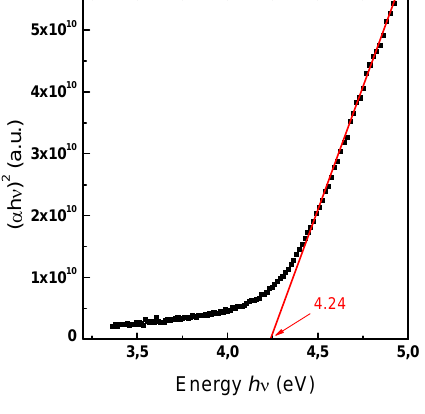
Figure 8. Plot of (  h  ) 2 vs photon energy h  of the SnO line). The closed line represents the linear fit.